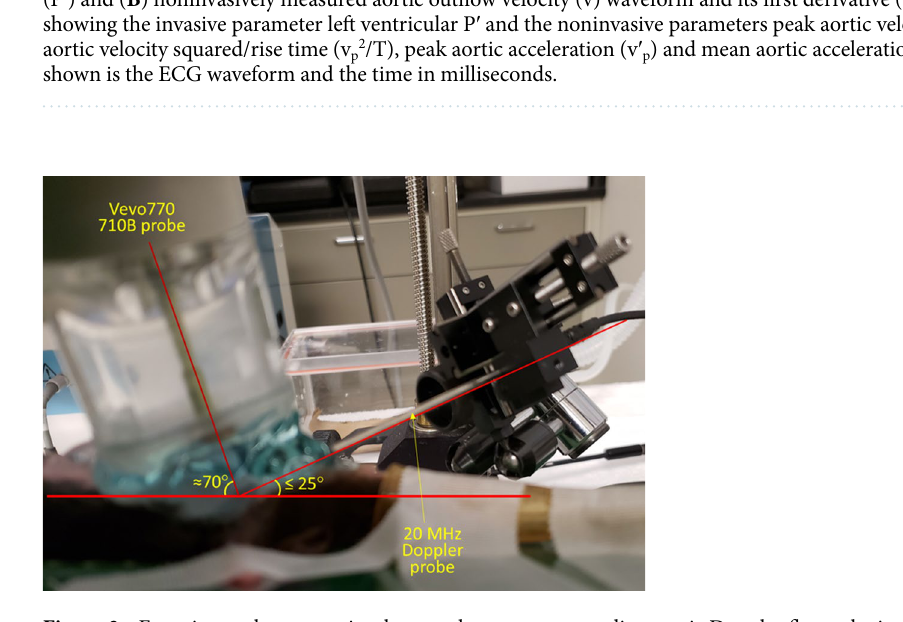
Figure 3. Experimental setup to simultaneously measure ascending aortic Doppler flow velocity using DFVS, left ventricular dimensions and ascending aortic flow velocity using VEVO770 system with 710B probe. Also, shown in the figure are lines representing the horizontal plane, and the angle of orientation of 20 MHz Doppler probe (≤ 25°) and that of the 710B probe